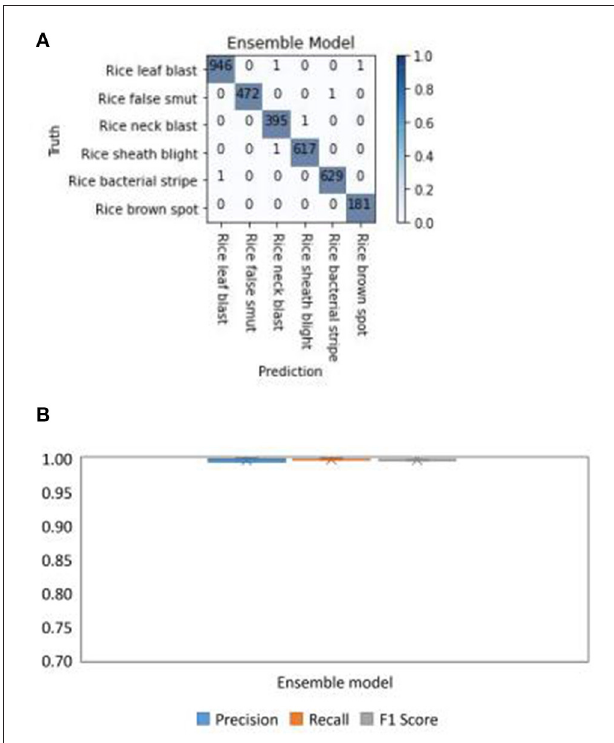
FIGURE 9 | Test results of the Ensemble Model for different types of rice disease with the split test set of images. (A) The confusion matrix and (B) the boxplots of the precision, recall, and F1 score for the Ensemble model in diagnosing six rice